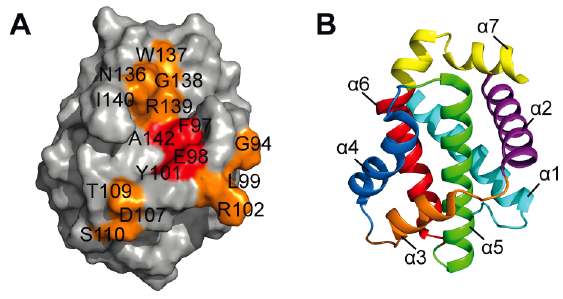
Figure 2. Binding site of fragment 1 mapped onto the protein Bcl-xL surface. (A) The combined shift perturbations CSP ( H z N ) induced by fragment 1 mapped onto the protein surface. Residues that exhibit large perturbations are displayed in red (CSP ( H z N ) § 0 : 4 ppm ) and orange ( 0 : 4 w CSP ( H z N ) § 0 : 15 ppm). (B) Ribbon structure of Bcl-xL in the free state (PDB code 1R2D) with the